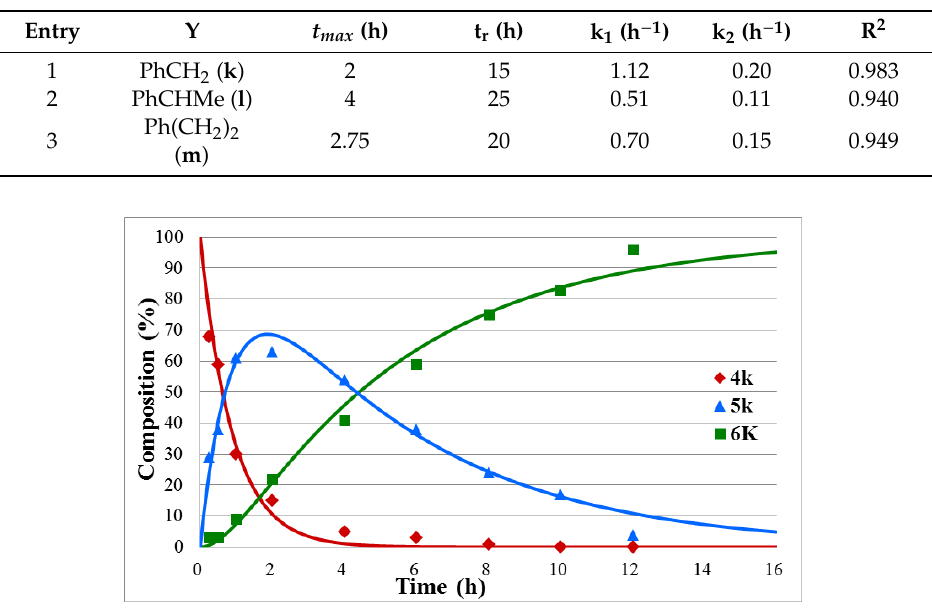
Figure 3. Concentration profile for the components during the hydrolysis of diethyl benzylphosphonate ( 4k ) under optimum conditions. The R 2 measure of goodness of fit is 0.983.